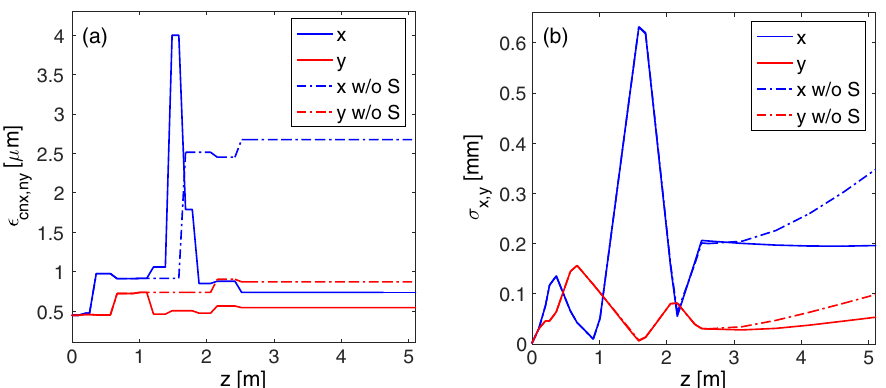
FIG. 3. Evolutions of the LPA beam properties with (solid) and without (dash-dotted) chromatic correction, respectively. (a) Evolutions of the normalized projected rms transverse emittances. (b) Evolutions of the rms beam sizes along the beam line. Note: the emittances of x are without dispersion